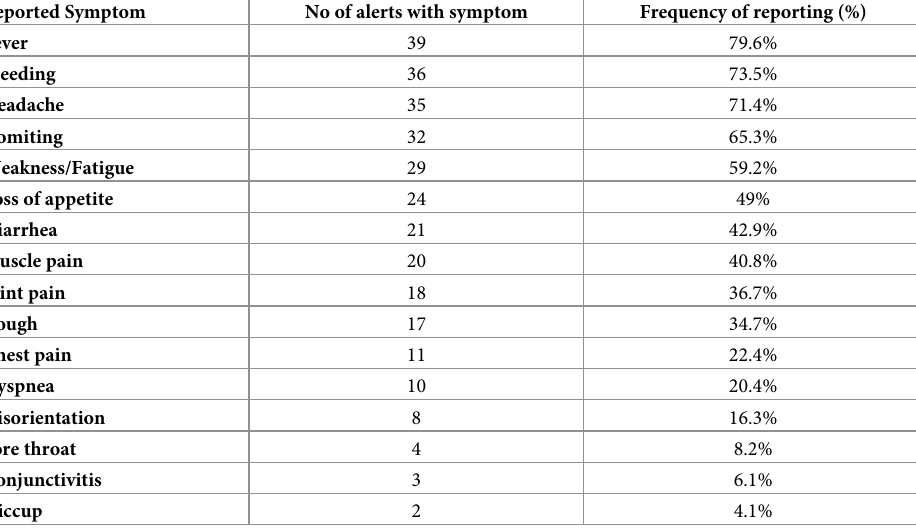
Table 3. Symptoms associated with EVD alerts in South Sudan–August 2018 to November 2019 (n = 49). Reported